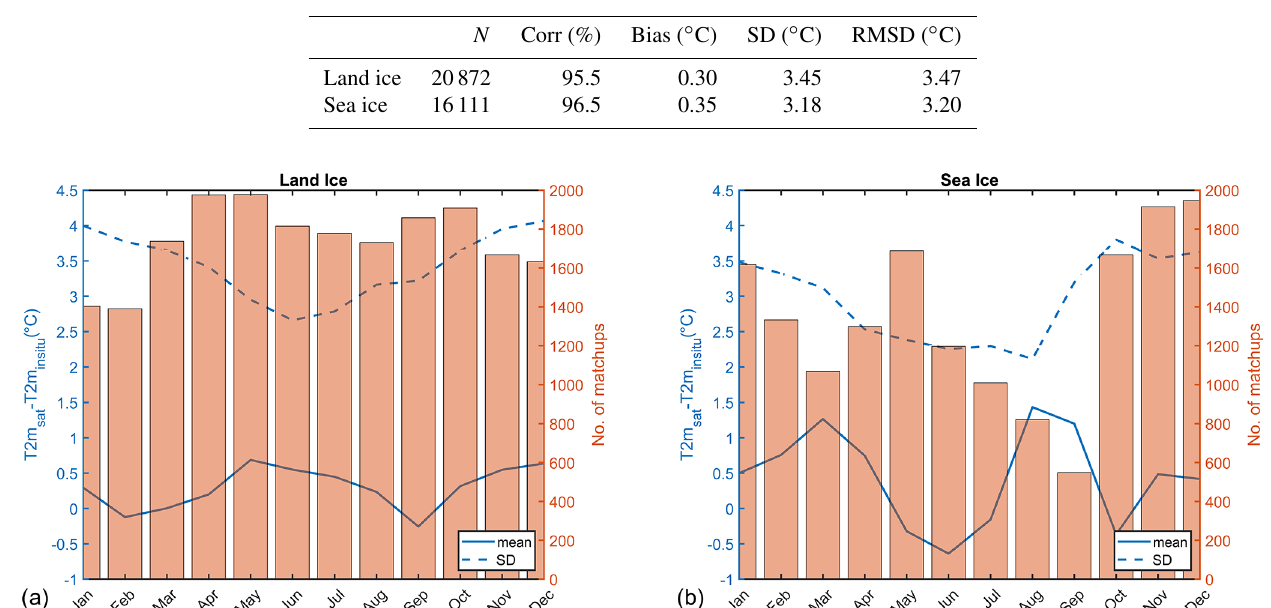
Figure 7. Estimated T2m minus observed T2m averaged for each month for (a) land ice and (b) sea ice. The dashed lines are standard deviations while the solid lines are biases. The bars show the average number of matchups for each